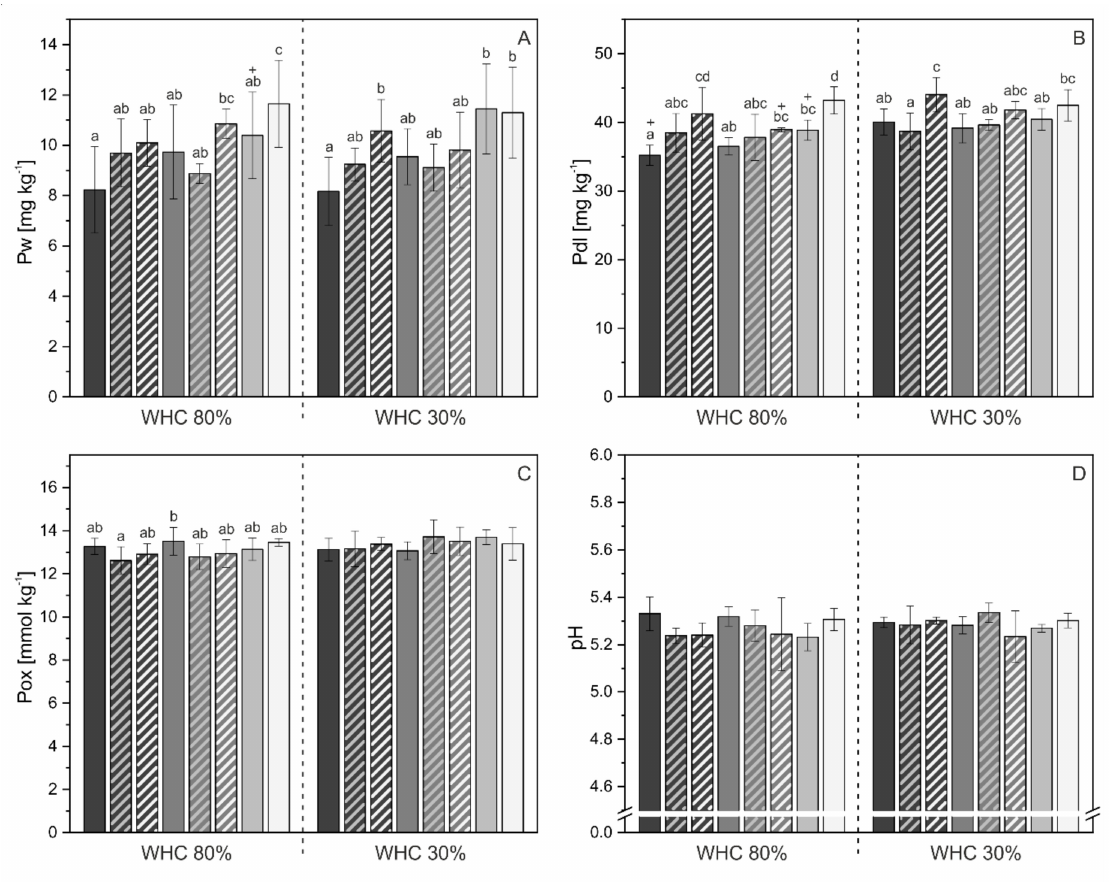
Figure 7. E ff ect of water supply and crops on water-extractable phosphorus (Pw, A ), double lactate-extractable phosphorus (Pdl, B ), oxalate-soluble phosphorus (Pox, C ) and pH ( D ) in soil after harvest in the Water-Trial (mean ± SD). Di ff erent letters indicate significant di ff erences between the crop variants at each water level, + indicates di ff erences between the water levels (ANOVA and Duncan’s test, p ≤ 0.05). WHC = water holding